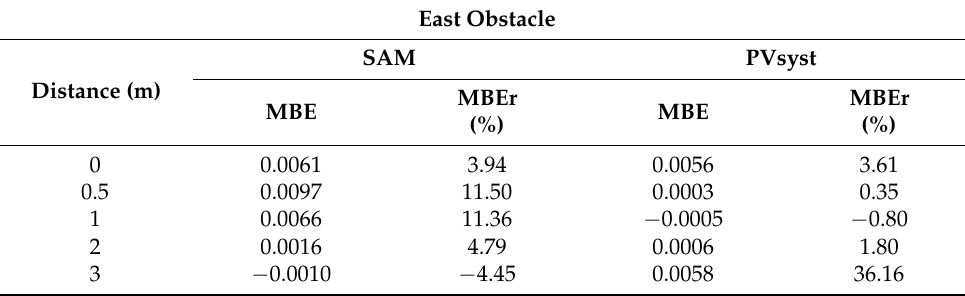
Figure 23. Diffuse shading factor for a module shaded by an infinite row, assuming different distances of separation. Table 5. MBE for the diffuse shading factor f D . East obstacle.